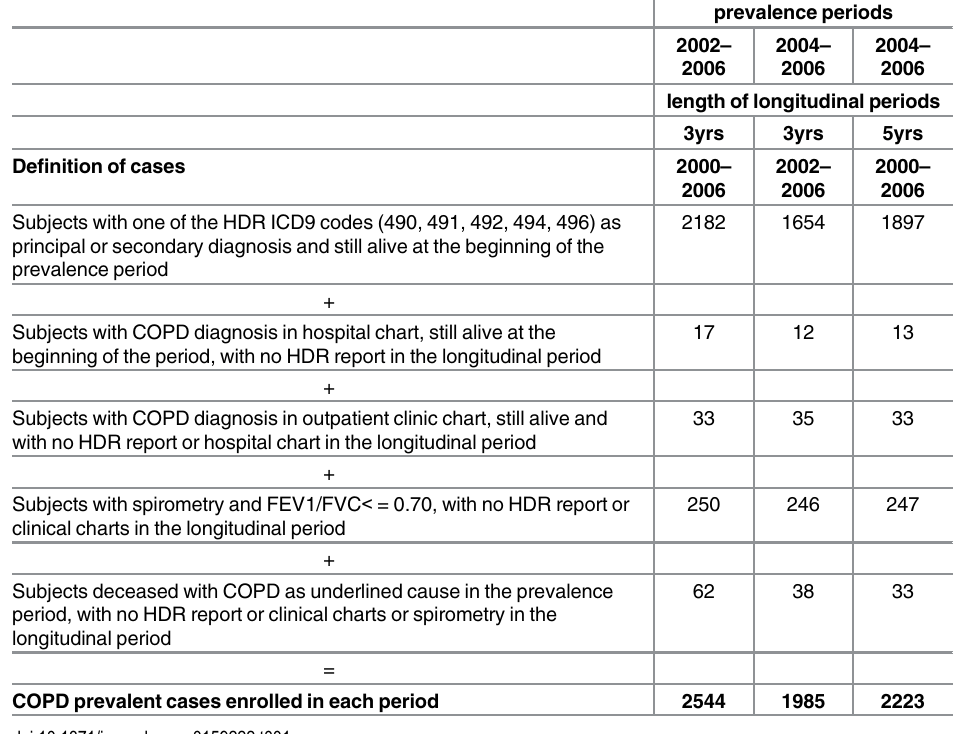
Table 1. Algorithm for enrollment of COPD cases and contributing to COPD prevalence, according to prevalence periods and length of longitudinal